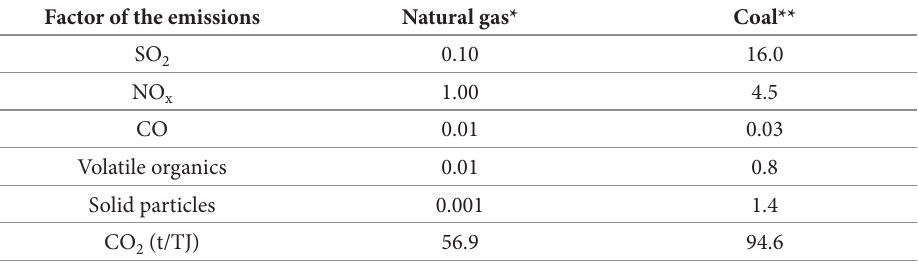
Table 4. Factor of the emissions of natural gas and coal